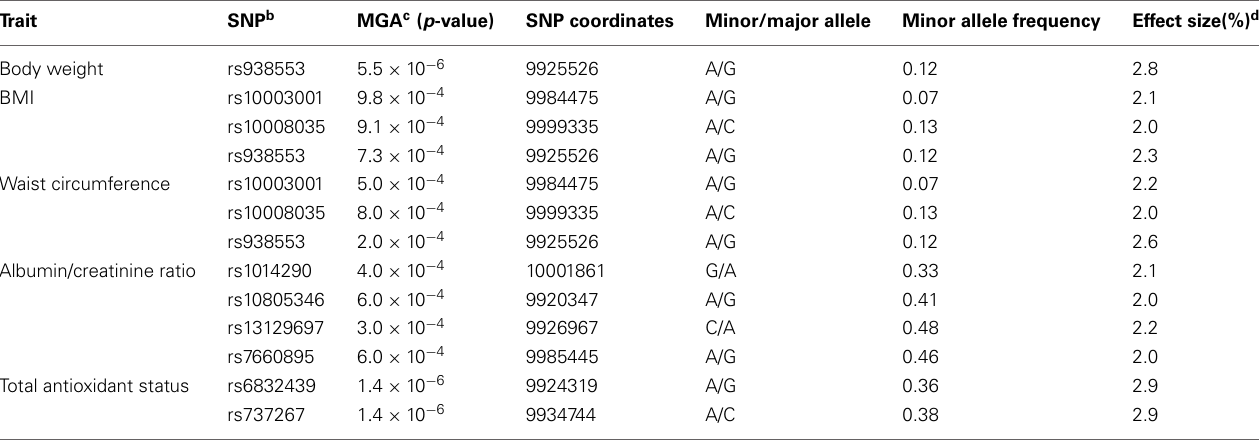
Table 3 | Solute carrier protein 2 family, member 9 ( SLC2A9 ) SNPs (chromosome 4) associated with cardiovascular or renal disease risk factors.